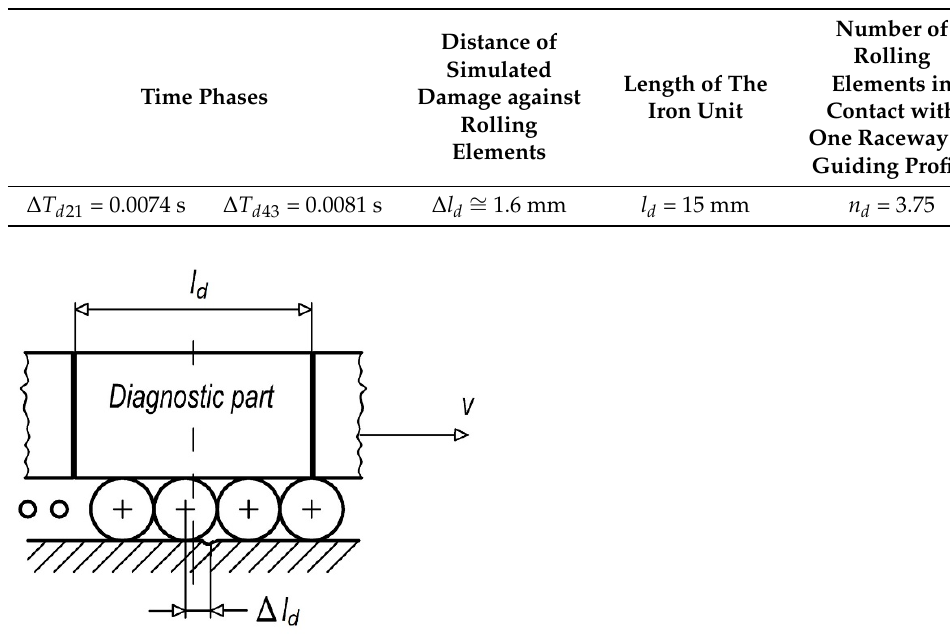
Table 10. Results of Equations (24)–(27).